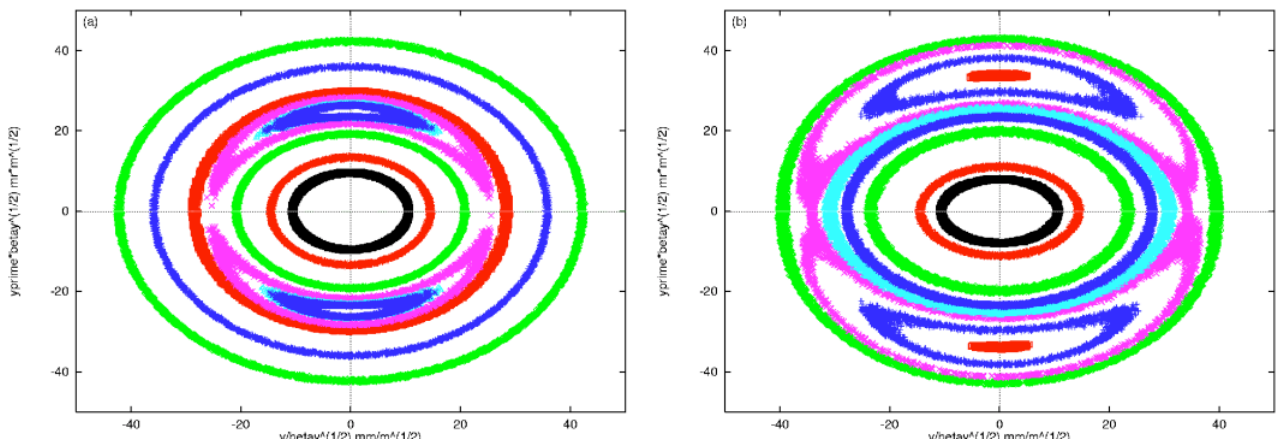
FIG. 9. (Color) PCM Poincaré plots of vertical phase space for (a) 10% and (b) 40% rms radial mismatches with 1 3 10 14 particles.